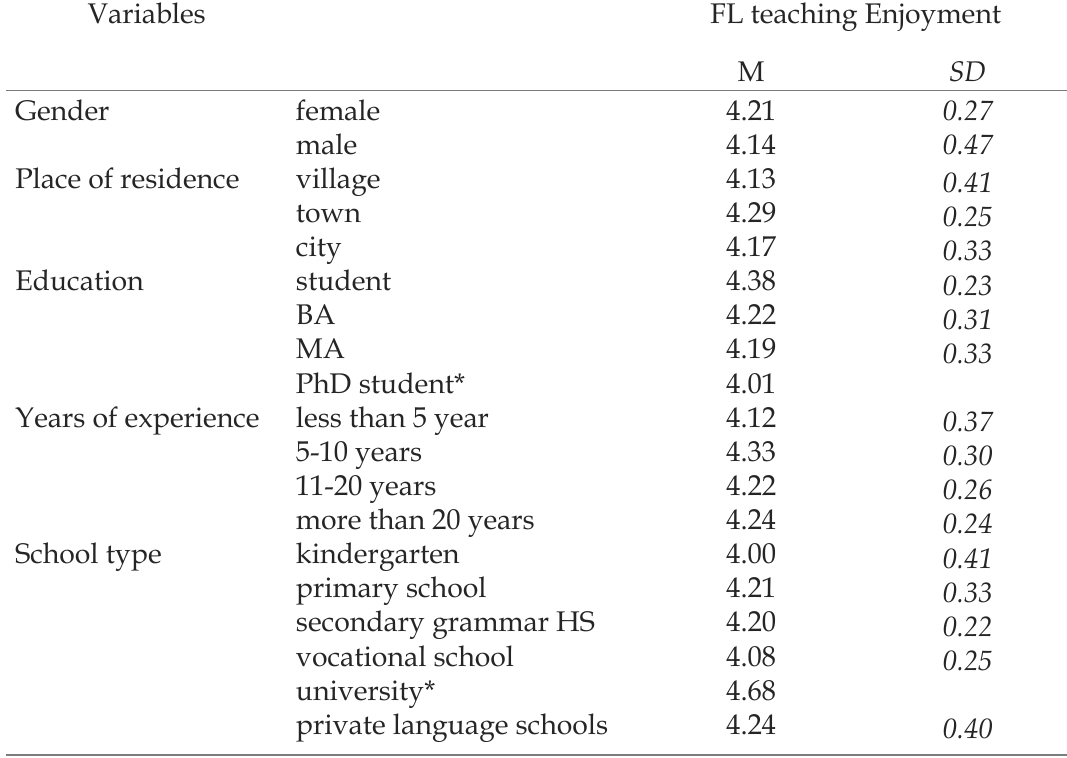
FL teaching Enjoyment according to independent variables